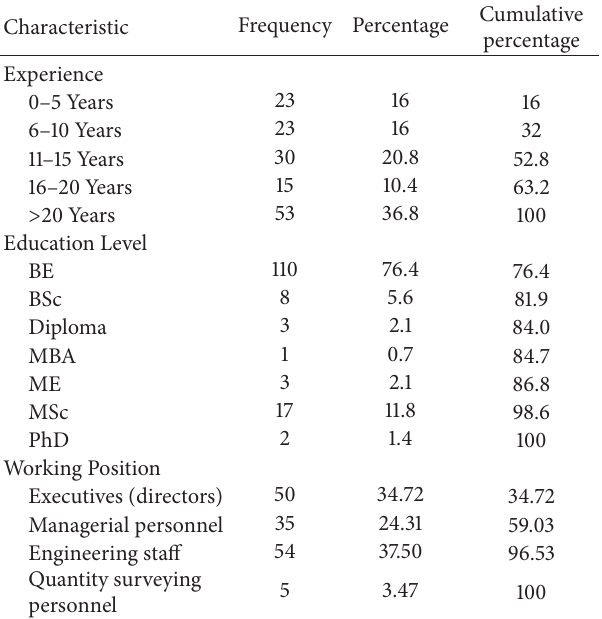
Table 1: Characteristics of the